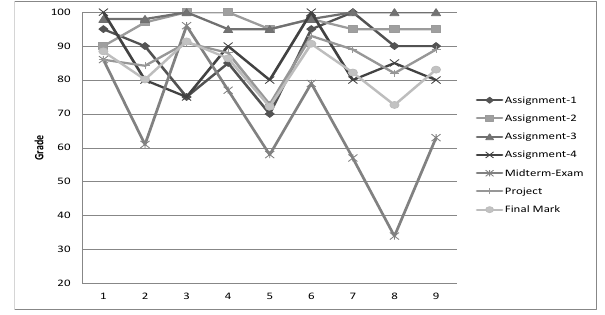
Figure 3. Assessments Results for QU